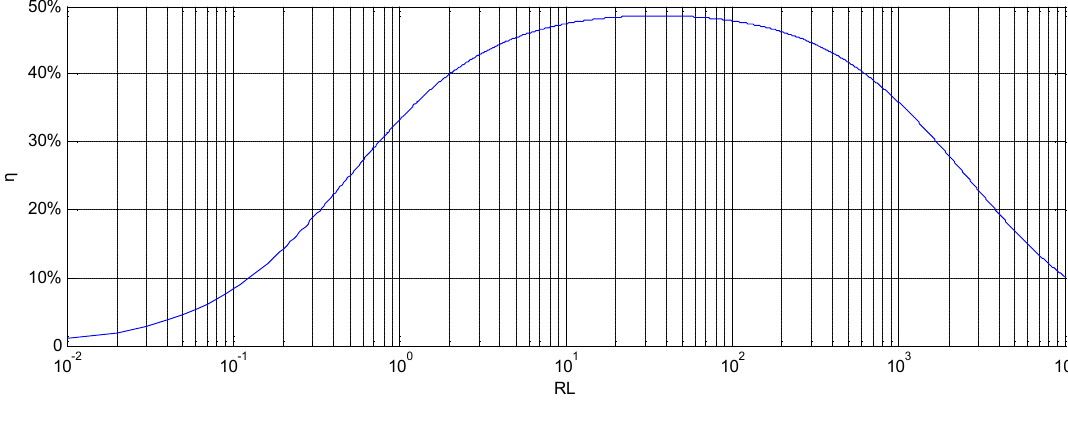
Figure 2. System efficiency versus load impedance curve.